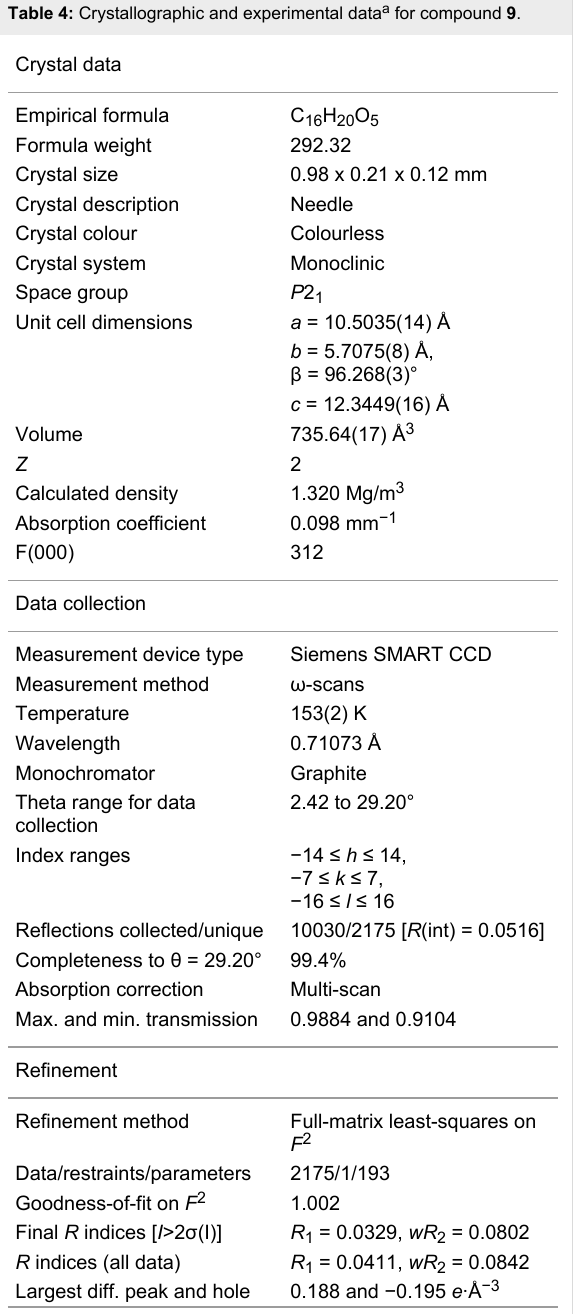
Table 4: Crystallographic and experimental data a for compound 9